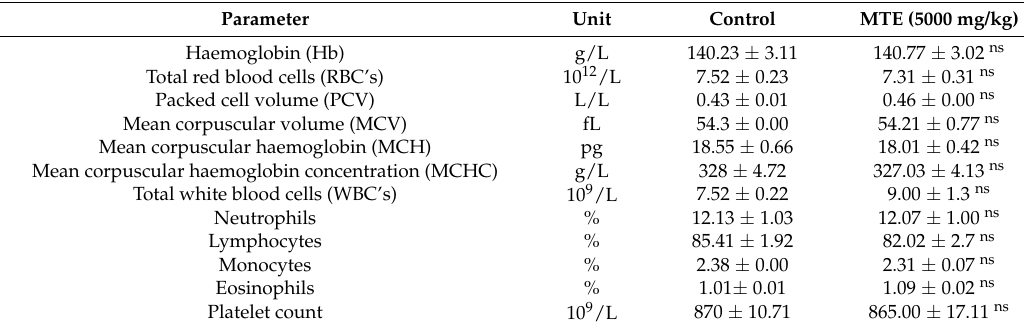
Table 2. Effect of MTEon haematological parameters in acute oral toxicity study.